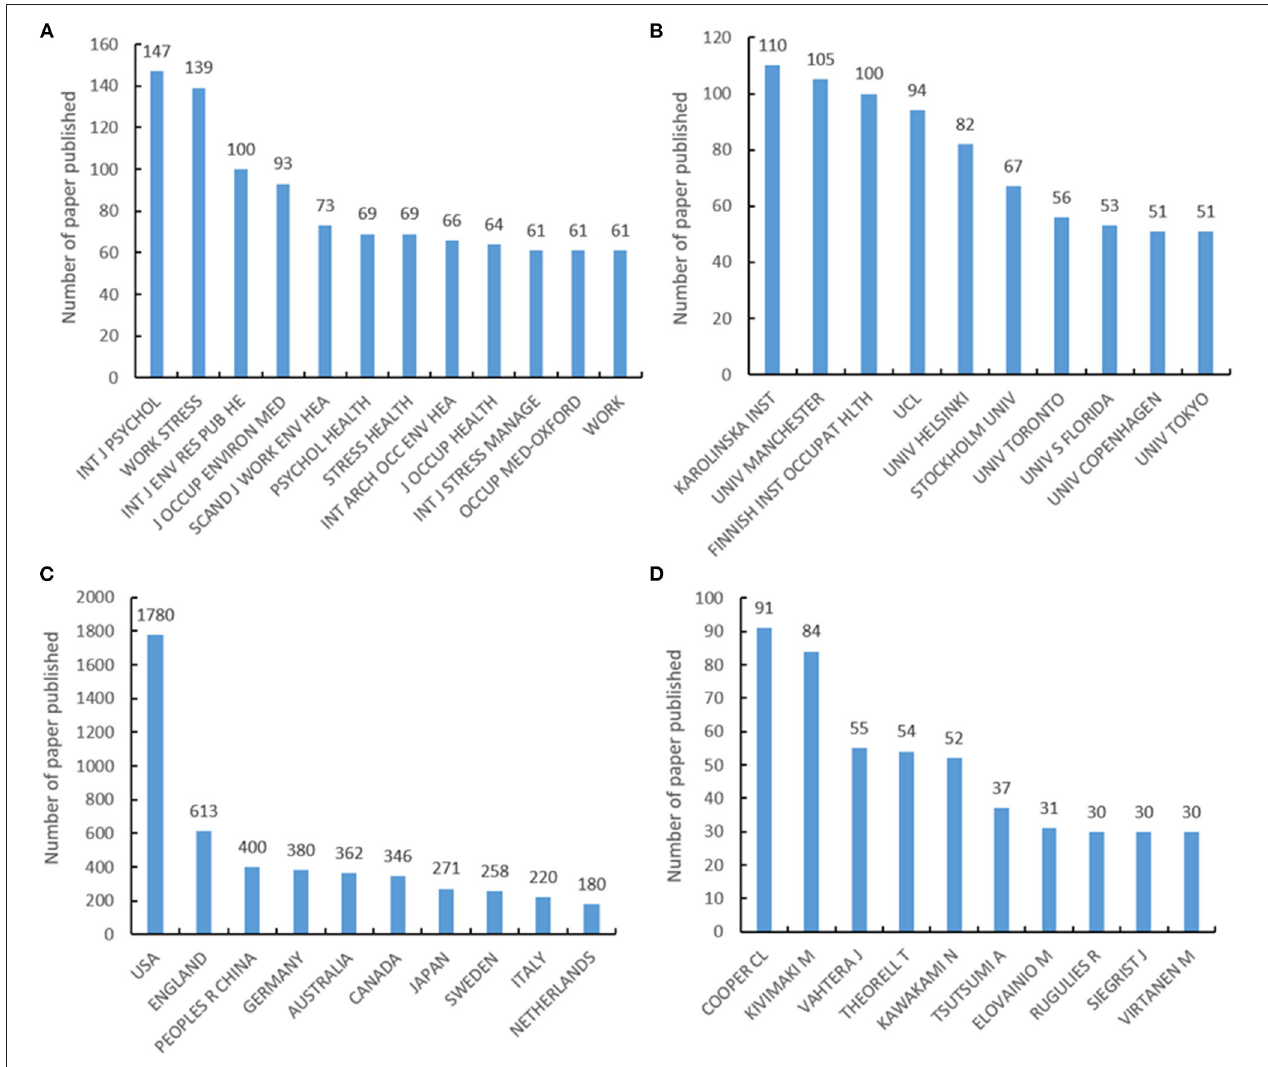
FIGURE 2 | The top 10 most published journals, organizations, countries, and authors of occupational stress publications. (A) The top 10 most published journals of occupational stress publications. (B) The top 10 most published organizations of occupational stress publications. (C) The top 10 most published countries of occupational stress publications. (D) The top 10 most published authors of occupational stress